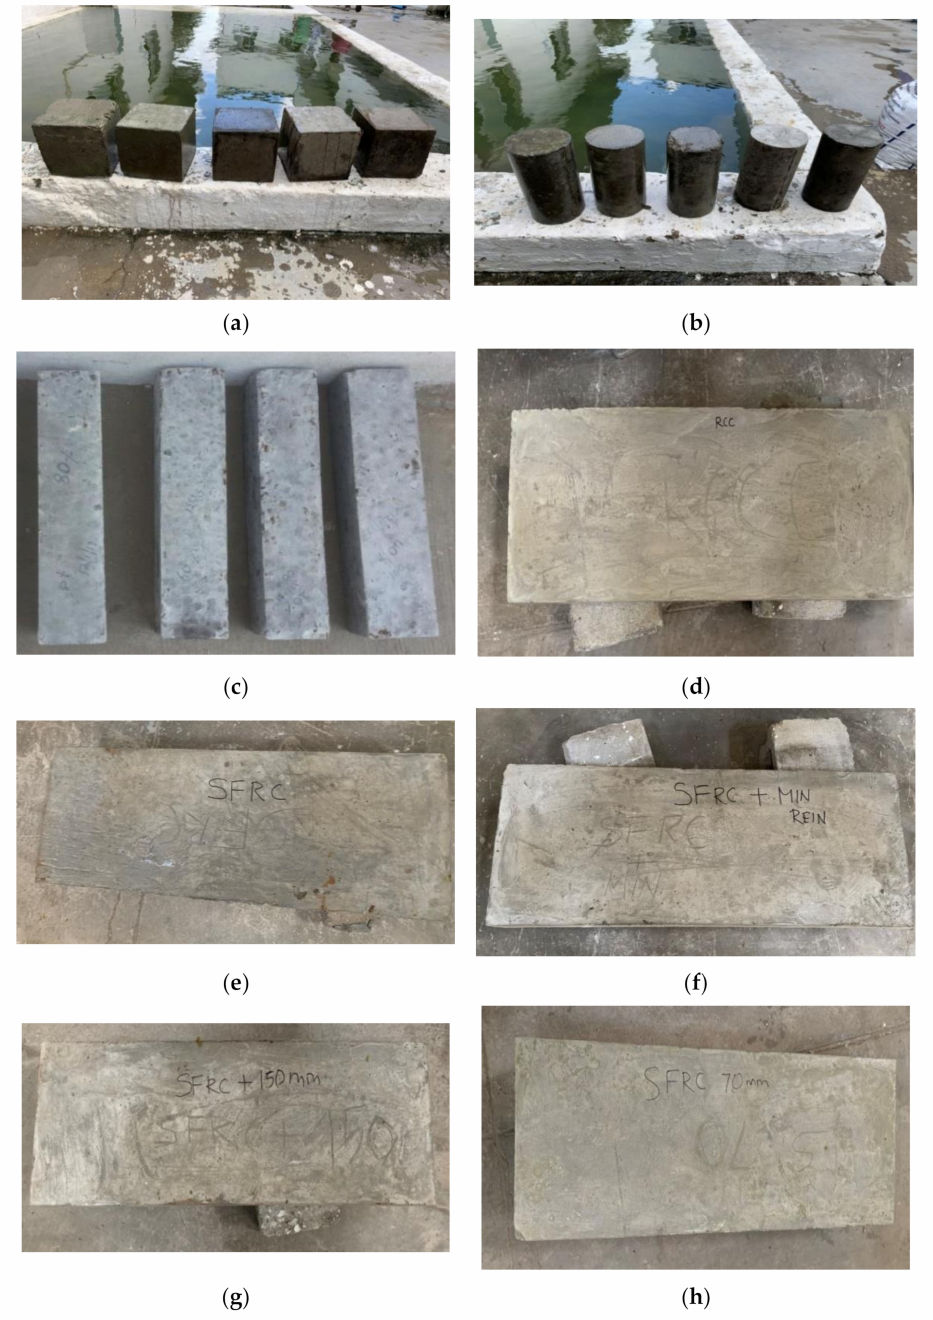
Figure 4. Test specimens ( a , b ) the cube specimens and cylinder specimens; ( c ) flexure beam specimen; ( d ) RCC slab specimen; ( e ) SFRC slab specimen; ( f ) SFRC + min rein specimen; ( g ) SFRC + 150 mm specimen; ( h ) SFRC + 70 mm